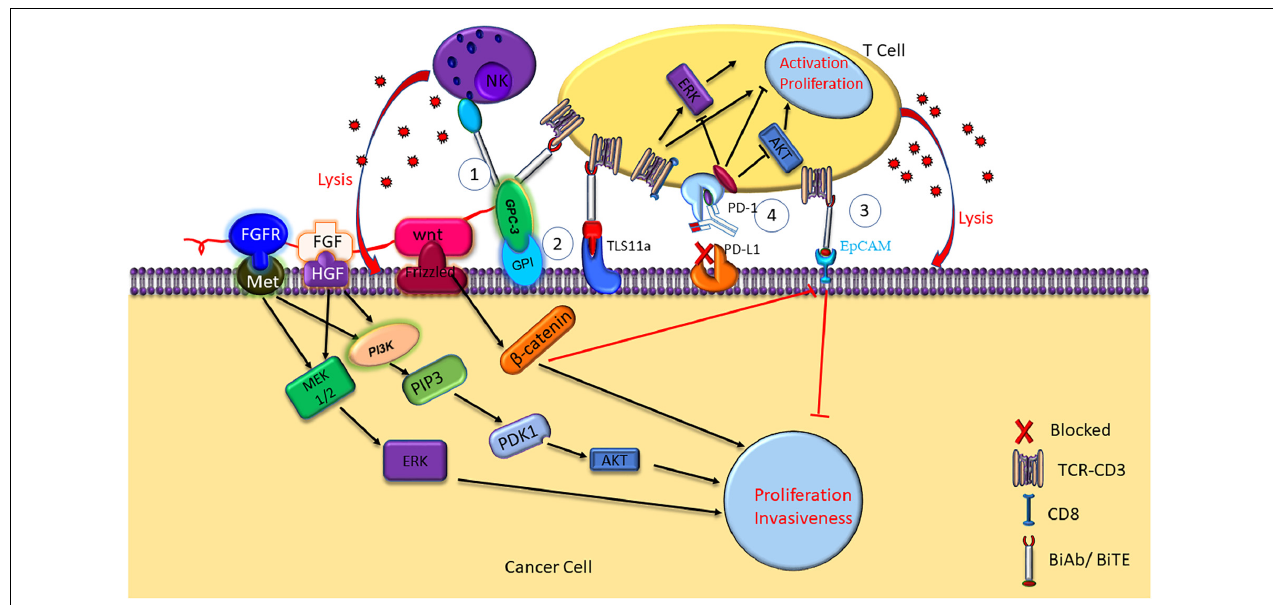
FIGURE 1 | Mechanisms of HCC immunotherapy targeting GPC3, TLS11a, EpCAM, and PD-1. NK BsAb and BiTE mediate T cell immunotherapy targeting GPC3 + HCC. GPC3 promotes HCC growth by upregulating the Wnt- β -catenin and FGF signaling. Aptamer bispecific antibody TLS11a/CD3 can mediate T cell immunotherapy by binding to both the HCC cancer cell and the T cell, inducing T cell cytotoxicity and proinflammatory cytokine release, such as IL-2, IL-6, IL-10, TNF- α , and IFN- γ . BiTE mediates T cell immunotherapy targeting EpCAM + HCC. Antibodies against PD-1 or PD-L1/2 on the cell surface inhibit the immune check point, and block the immune escape in